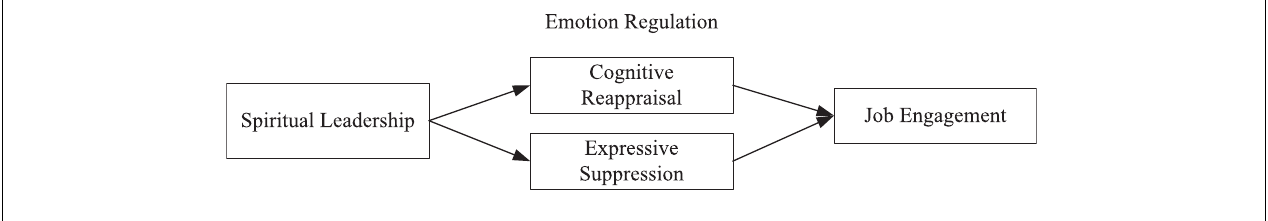
FIGURE 1 | Theoretical